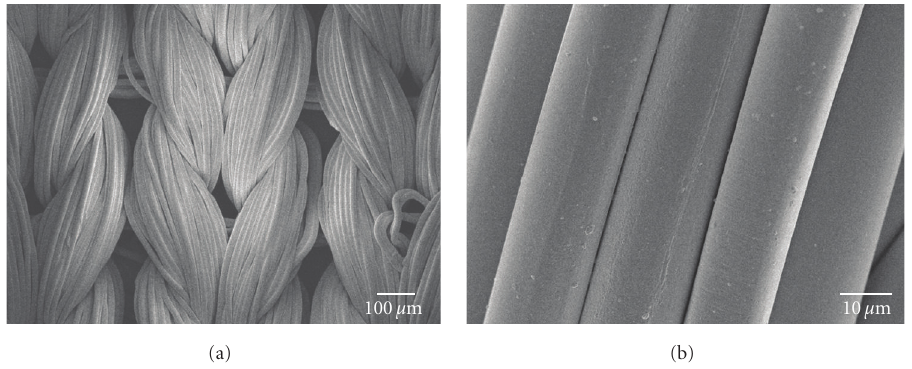
Figure 1: FE-SEM images of the PLA-fiber sheet used. (a) Magnification × 100. (b) Magnification × 2,000.